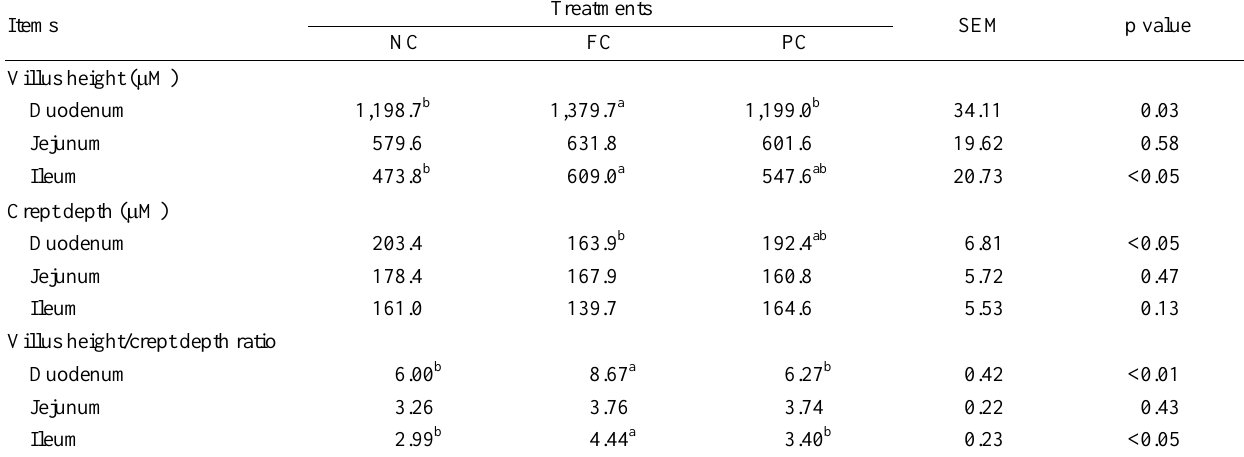
Table 5. Effects of dietary Forsythia suspensa extract (FSE) supplement on small intestinal morphology in broilers